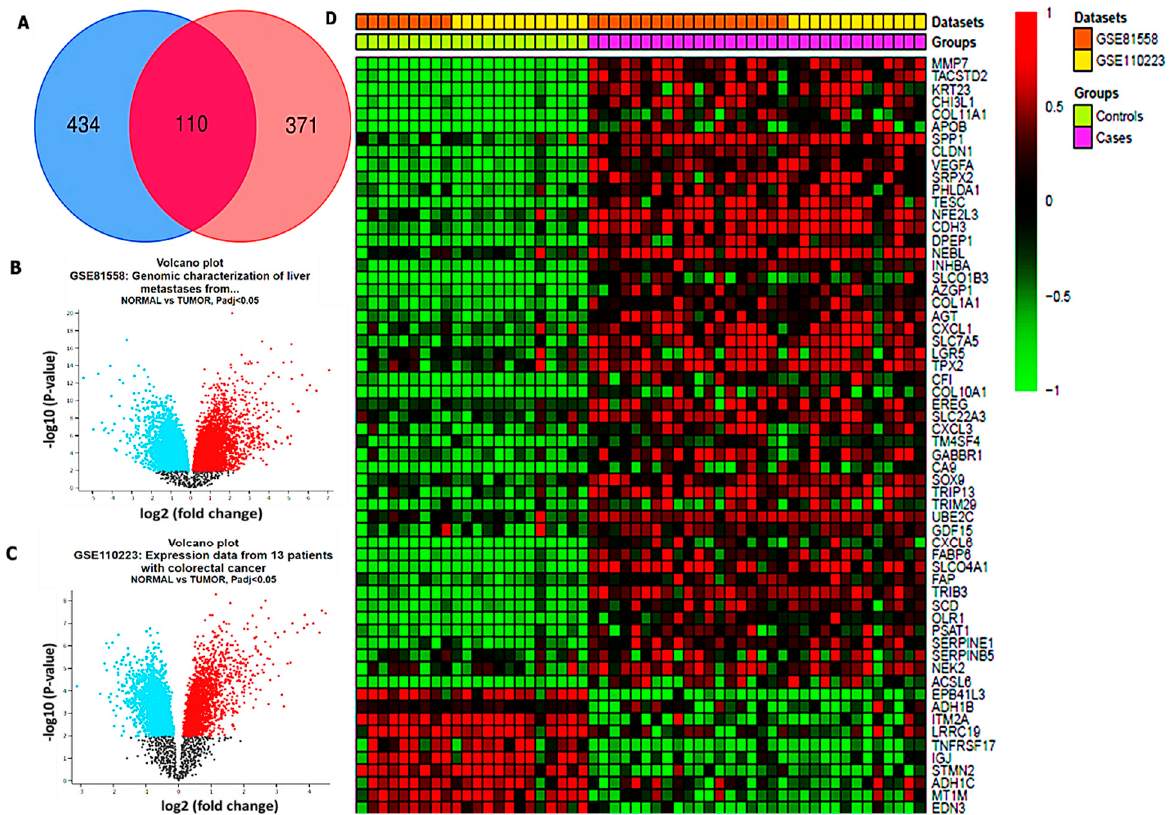
Figure 3. Microarray data mining of gene expression profiling in colorectal cancer (CRC). ( A ) Venn diagram showing overlapping genes obtained from the GSE81558 and GSE3110223 microarray datasets. ( B , C ) Volcano plots showing downregulated and upregulated genes in normal and tumor samples, respectively (at p < 0.05). ( D ) shows the heatmap of overexpressed overlapping genes in CRC.